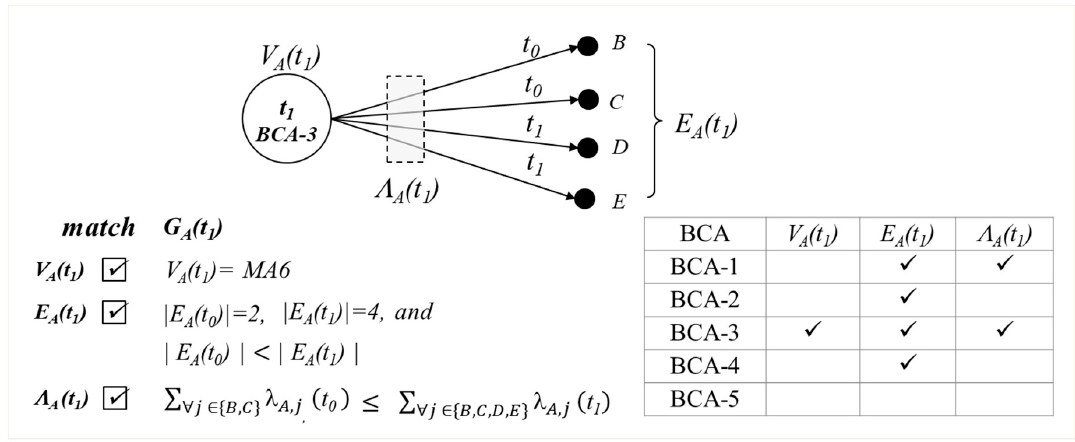
Figure 3. BCA-3 detection of G A.